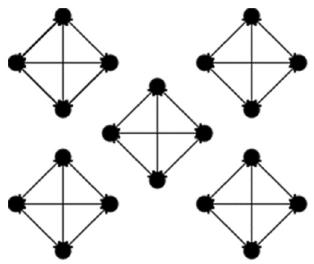
Figure 2. Multiple mesh network topology.